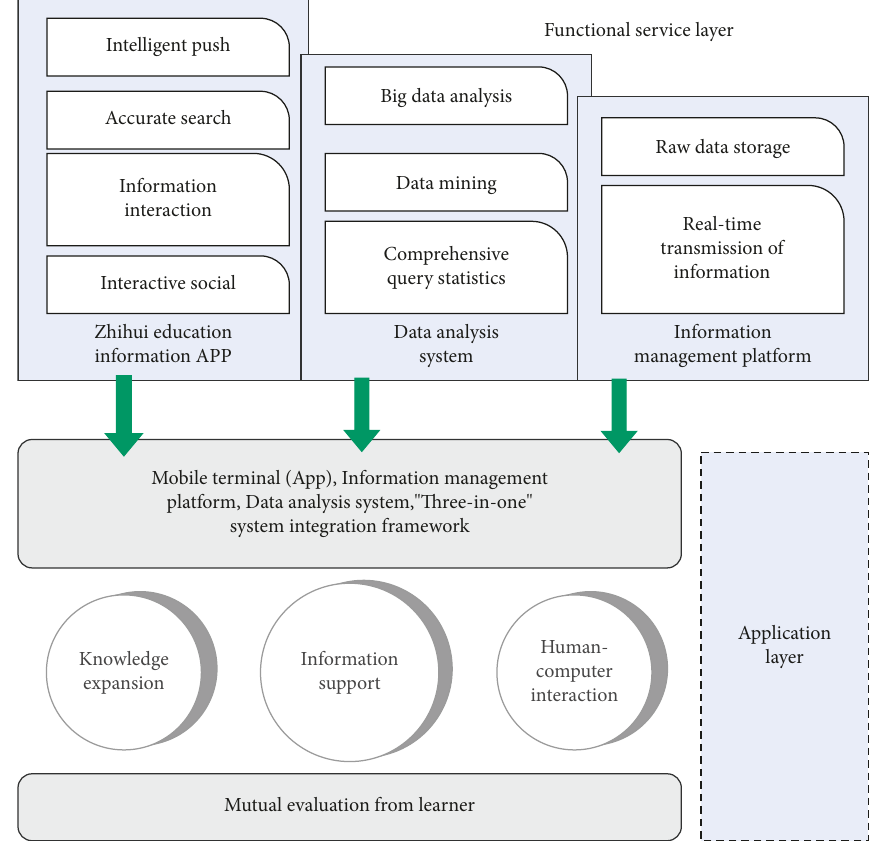
Figure 9: Informationalized labor education practice